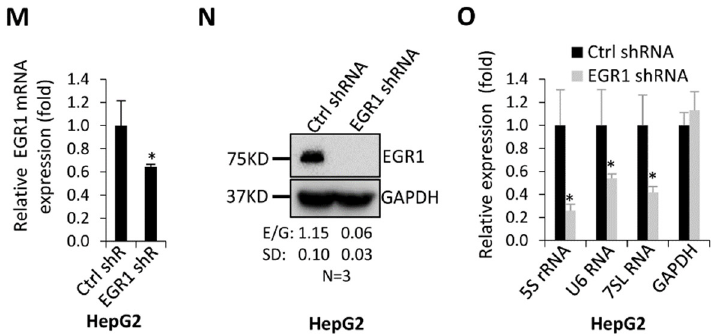
Figure 1. EGR1 downregulation inhibited the expression of Pol III products: ( A – C ) EGR1 siRNA transfection reduced expression of Pol III products in 293T cells. In this study, 293T cells were seeded in 12-well plates and transfected with EGR1 siRNA. After 48 h, EGR1 expression was mon- itored by RT-qPCR ( A ) and Western blotting ( B ). Pol III products were analysed by RT-qPCR ( C ); ( D – F ) EGR1 siRNA transfection inhibited the expression of Pol III products in HeLa cells. HeLa cells were transfected as for 293T cells. EGR1 expression was examined by RT-qPCR ( D ) and Western blotting ( E ), and Pol III products were analysed by RT-qPCR ( F ); ( G – I ) EGR1 shRNA stable expres- sion impeded Pol-III-directed transcription in 293T cells. Briefly, 293T cell lines stably expressing EGR1 shRNA or control shRNA were generated using a lentiviral infection system. EGR1 expression was determined by RT-qPCR ( G ) and Western blotting ( H ), and Pol III products were detected by RT-qPCR ( I ); ( J – L ) EGR1 shRNA stable expression repressed Pol-III-directed transcription in HeLa cells. HeLa cell lines stably expressing EGR1 shRNA or control shRNA were generated using a lentiviral infection system. EGR1 expression was determined by RT-qPCR ( J ) and Western blot ( K ), and Pol III products were analysed by RT-qPCR ( L ); ( M – O ) EGR1 shRNA stable expression inhibited the expression of Pol III products in HepG2 cells. HepG2 cell lines stably expressing EGR1 shRNA or control shRNA were generated with a similar procedure as that for 293T cells. EGR1 expression was examined by RT-qPCR ( M ) and Western blotting ( N ), and Pol III products were monitored by RT-qPCR ( O ). E/G in ( B , E , H , K , N ) represents the ratio of the EGR1 (E) intensity to the GAPDH (G) intensity ( n = 3); SD, standard deviation. Each column in the bar graphs represents the mean ± SD of three biological replicates ( n = 3). *, p < 0.05; **, p < 0.01. The p values of different genes were obtained by Student’s t -test, performed with control and treatment